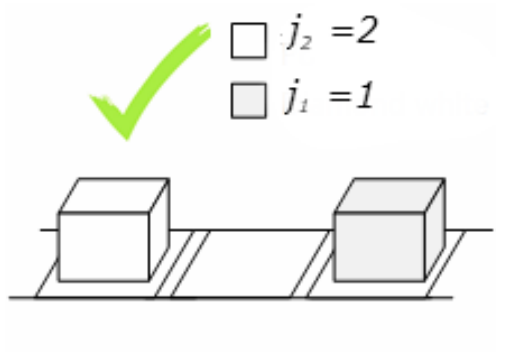
Figure 7. Diagram of Restriction C3.